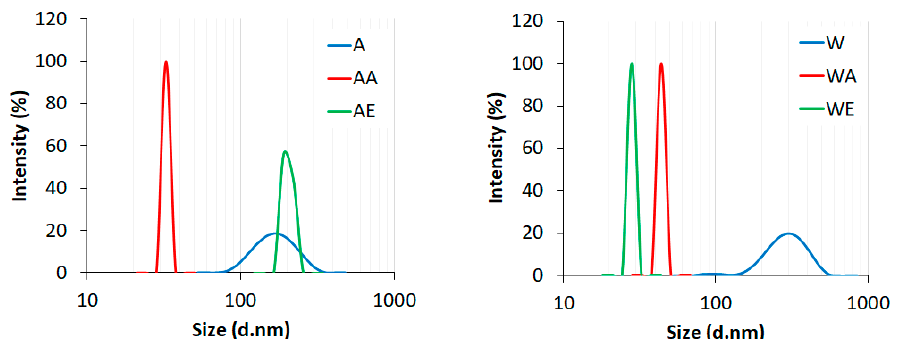
Figure 3. The average particle sizes of (A) enzyme-pretreated Avicel cellulose, (AA) enzyme-pretreated Avicel cellulose treated with AmimCl, (AE) enzyme-pretreated Avicel cellulose treated with EmimOAc, (W) enzyme-pretreated Whatman cellulose, (WA) enzyme-pretreated Whatman cellulose treated with AmimCl, and (WE) enzyme-pretreated Whatman cellulose treated with EmimOAc.